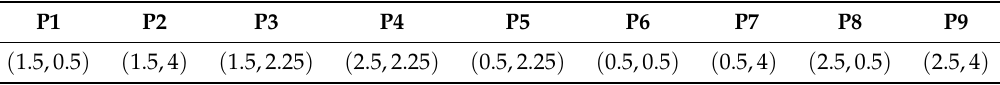
Figure 8. The layout of the transmitter, receiver and the nine testing positions. Table 2. Location of the testing points. The units of the coordinate are